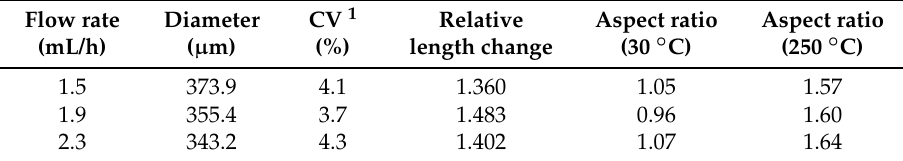
Table 1. Properties of liquid crystalline elastomer particles synthesized at different flow rates of the continuous phase. The diameter is averaged over the particles’ long and short axis at room temperature. The relative length change describes the ratio of a particle’s main axis in the actuated and the non-actuated state. The aspect ratio is defined as a particle’s main axis divided by the axis perpendicular to the main axis. (CV: Coefficient of